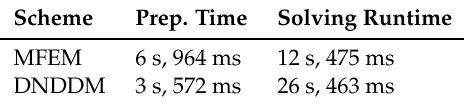
Table 3. MFEM versus DNDDM.